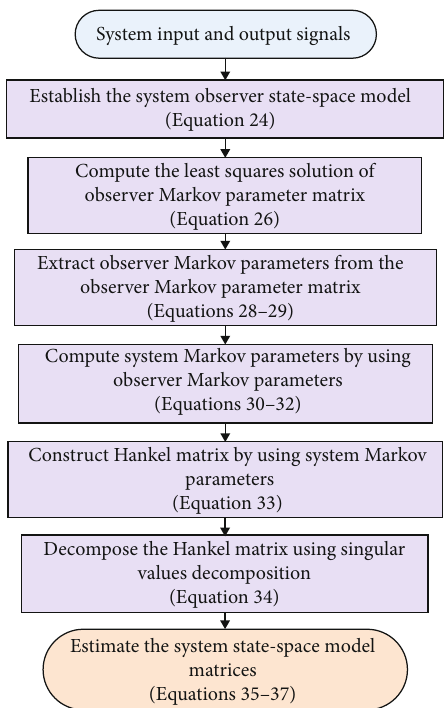
Figure 2: Computation procedure of the OKID